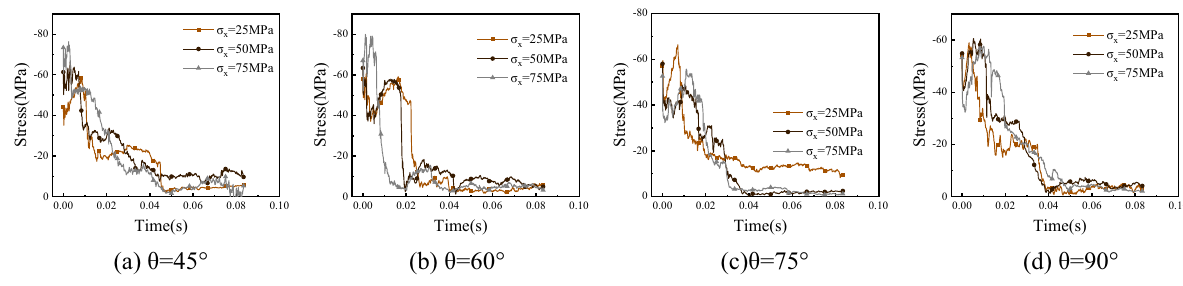
Fig. 24 Tangential stress with different σ x in the same inclined angles of joints (RQD = 50)